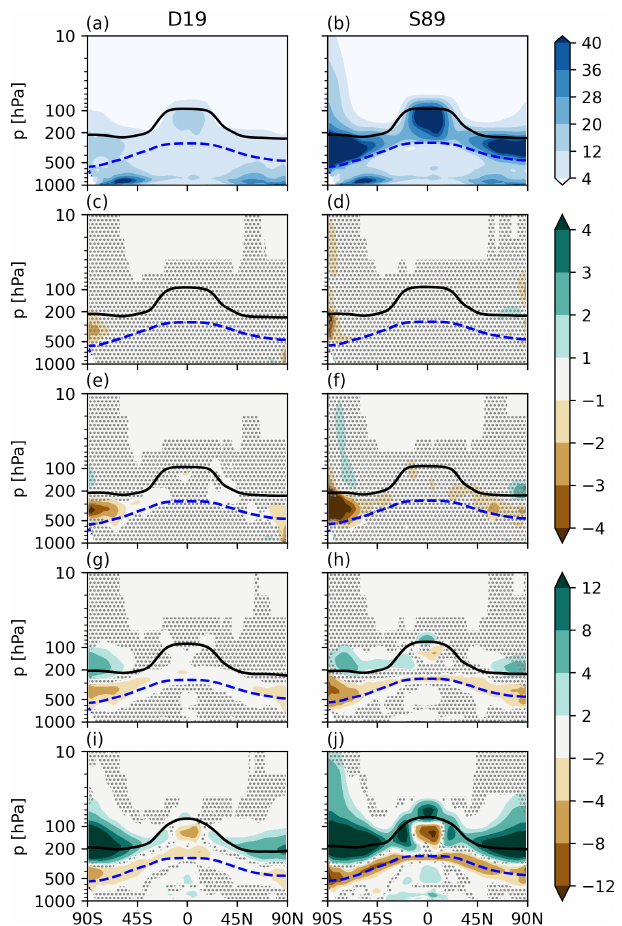
Figure 4. Five-year zonal mean cloud fractions (%) in pressure lev- els (hPa) for the D19 and S89 ice cloud fraction approaches for the unseeded reference cases (a–b) . The cloud fraction anomalies with respect to the unseeded reference cases are plotted in the subsequent rows for S i,seed = 1.05: Seed0.1 (c–d) , Seed1 (e–f) , Seed10 (g–h) , and Seed100 (i–j) . The black line is the 5-year mean zonal mean WMO-defined tropopause height on pressure levels, and the blue dashed line is the 238K isotherm. The stippling in the difference plots shows insignificant data points in the 95% confidence level according to the independent t test controlled by the false discovery rate method.